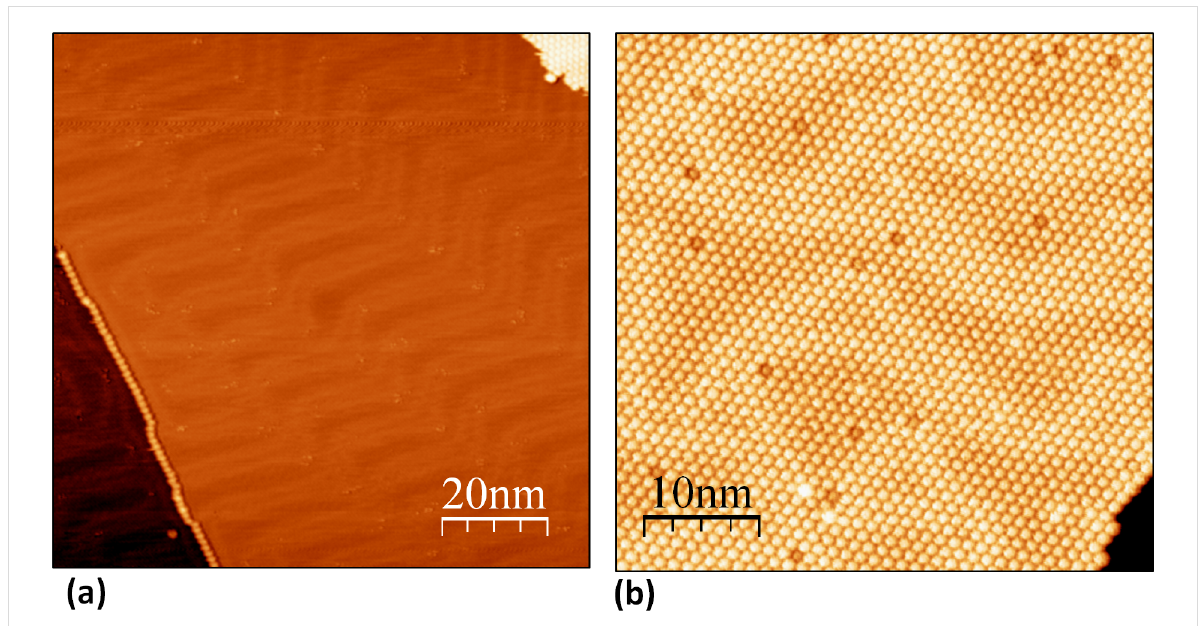
Figure 2: Topographic images ( U = 1.5 V; I = 0.2 nA) of Er 3 N@C 80 on Au(111). Figure (a) shows a one-dimensional chain of the endohedral fuller- enes at the monoatomic step edge of the reconstructed Au(111) surface. Due to the presence of the molecules the reconstruction lines are distorted and prevented to pass the molecule line at the step edge. The molecules are positioned at fcc terminated adsorption sites indicated by the discom- mensuration line course. At the upper right corner the 2D-monolayer is visible. A fullerene monolayer on Au(111) is shown in Figure (b). The mole- cules arrange in a hcp-structure with a nearest neighbor distance on about 1.15 ± 0.01 nm. Several fullerenes of the monolayer appear darker respec- tively brighter in the image. This effect, caused by the fullerene monolayer induced restructuring of the Au(111) interface, could be assigned to an anomalous electronic structure resulting from the proposed formation of nanopits at the Au(111) interface that consequently lead to a changed num- ber of Au-atoms interacting with the affected molecules [12,14]. Note that the presence of impurities cannot be excluded.